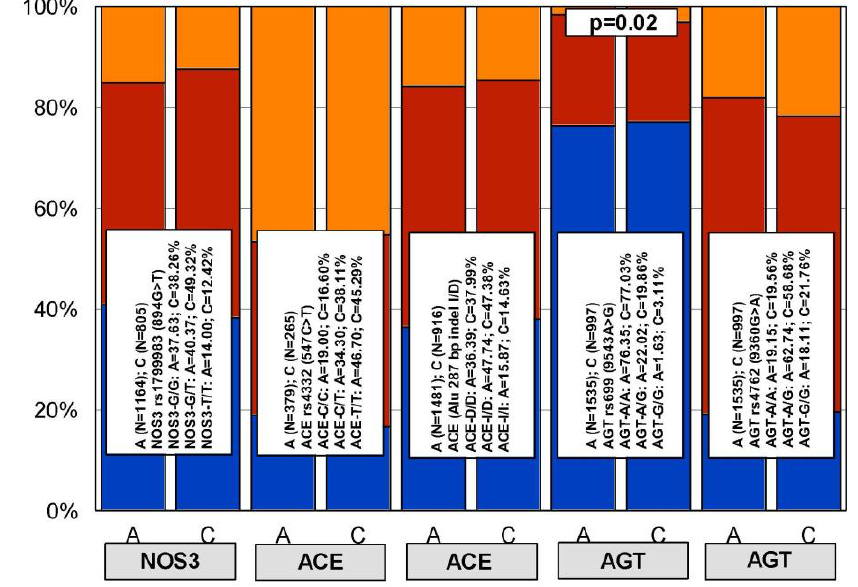
Figure 4. Distribution and frequency of polymorphic variants of the NOS3 , ACE , and AGT genes in the general population and in patients with Alzheimer’s disease. Color codes: Blue: NOS3-G/G , ACE-C/C , ACE-D/D , AGT-A/A ; Red: NOS3-G/T , ACE-C/T , ACE-I/D , AGT-A/G ; Orange: NOS3-T/T , ACE-C/T , ACE-I/I , AGT-G/G .